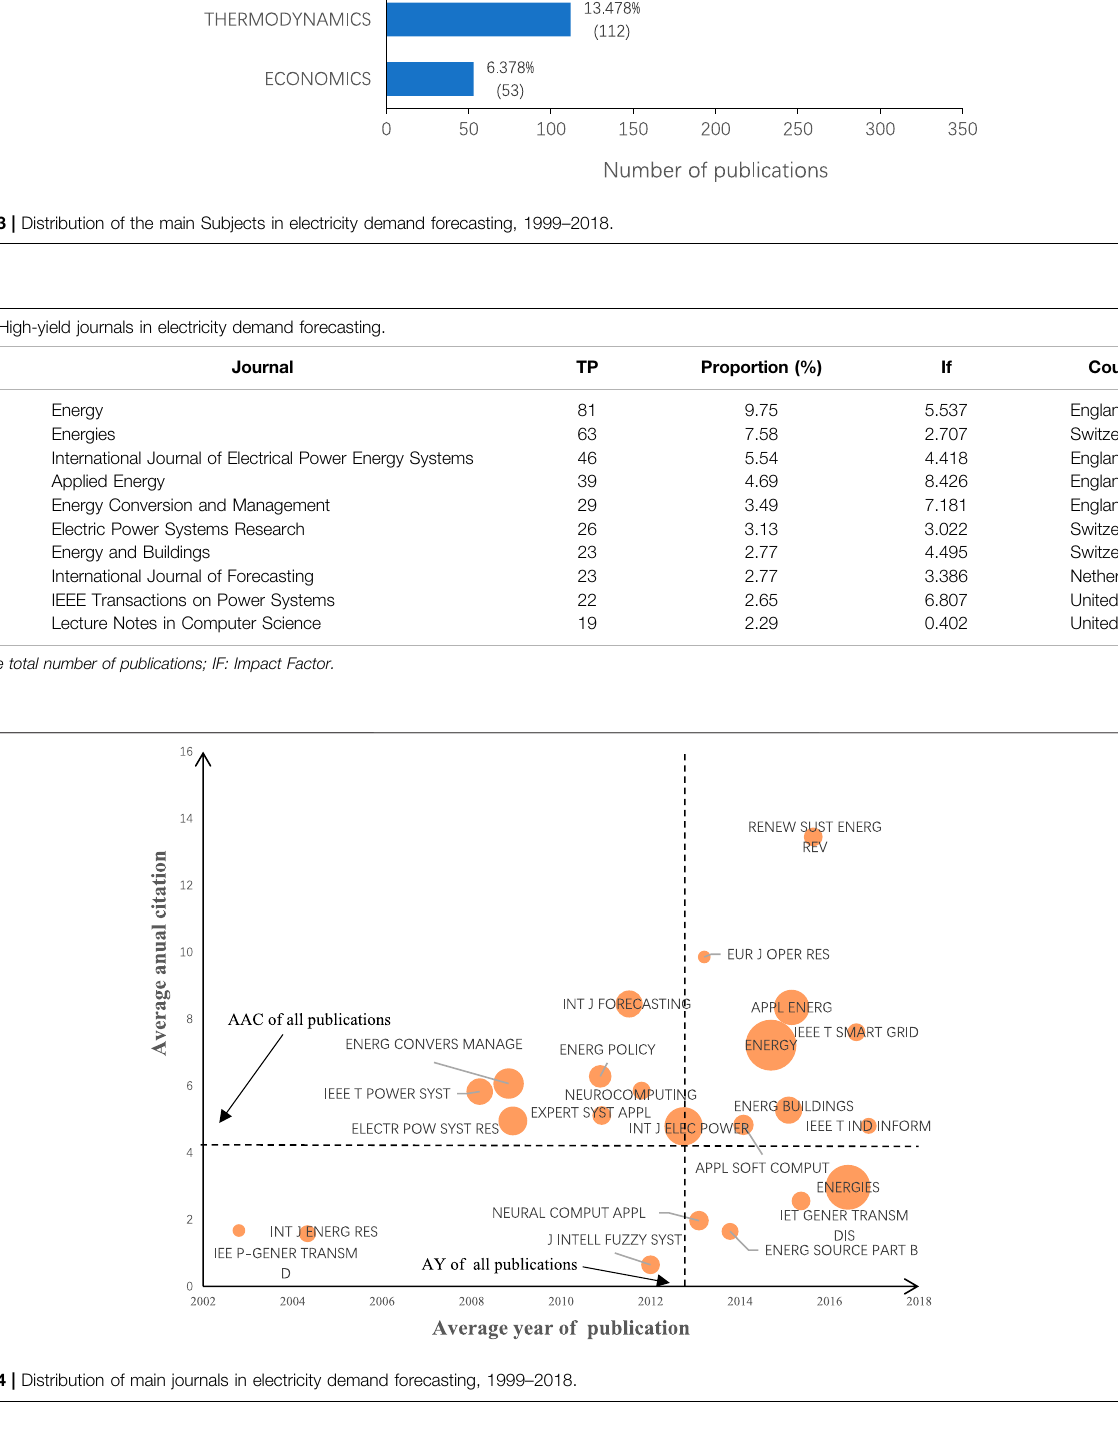
Frontiers in Energy Research |